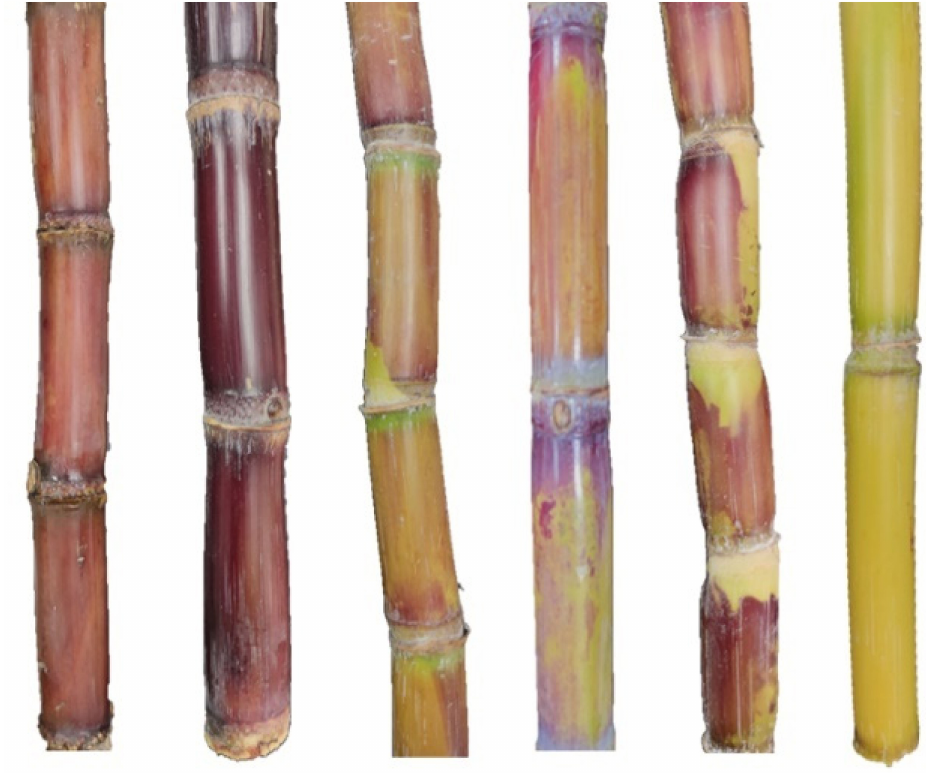
Figure 1. Six sugarcane cultivars in this study and their rind color. 2.1. Quantification of Anthocyanins in Six Distinct Cultivars Revealed Thirty Novel Compounds in Sugarcane A total of 108 flavonoid and anthocyanin compounds were tested in the rinds of six sug- arcane cultivars (Supplementary Table S1). Among them, 6 flavonoids and 43 anthocyanin derivatives were quantified from sugarcane rind (Table 1). These anthocyanin derivatives belong to 6 anthocyanin classes such as 10 cyanidin, 11 pelargonidin, 9 peonidin, 5 mal- vidin, 4 delphinidin, and 4 petunidin (Table 1). The extract ion flow chromatography, total ion flow chromatography (TIC), and anthocyanin compound peaks were observed during LCMS/MS operation (Supplementary Figure S2). The molecular weight, ionization mode, parent ion Q1 (Da), daughter ion Q3 (Da), retention time, and linear equation of the anthocyanin derivatives were listed in Table 1. Among 43 anthocyanin compounds, 30 were reported for the first time in sugarcane